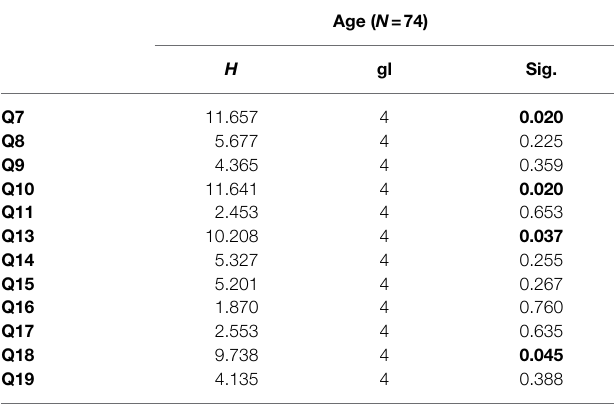
TABLE 5 | Kruskal-Wallis results for variable Q12 “I understand the goal I have to achieve in the metaphor.”